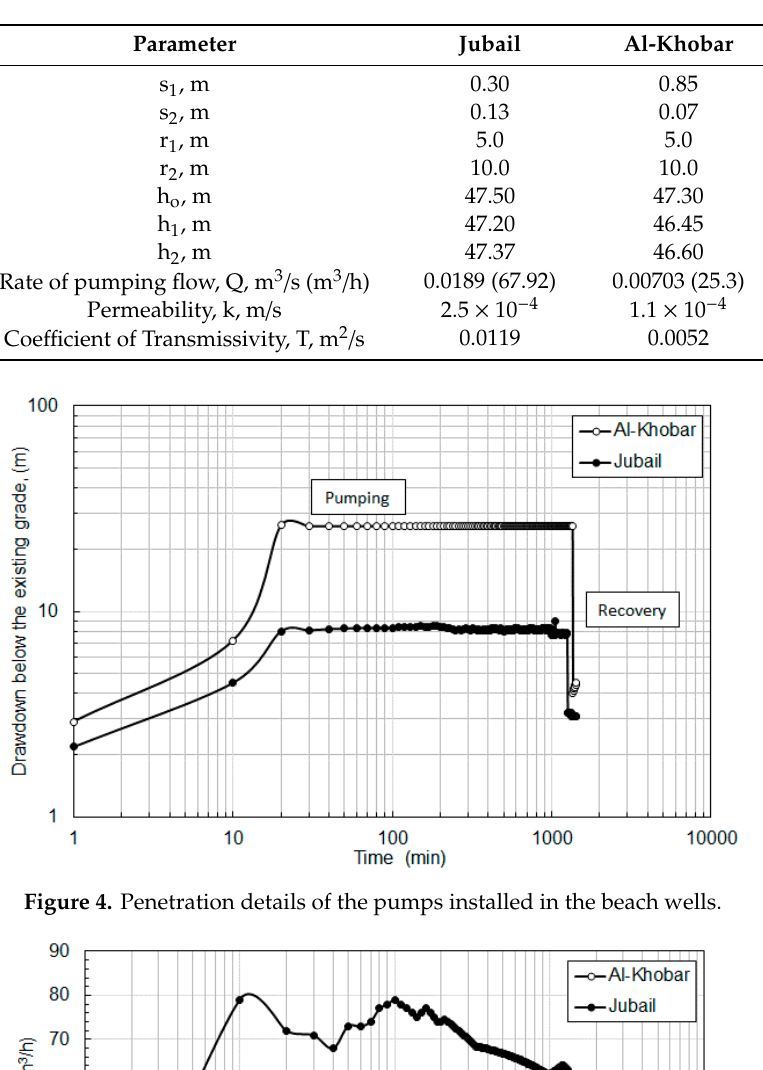
Table 1. Results obtained from the observation wells.